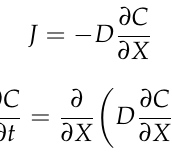
Figure 8. Microstructure and EDS result of interface between the TC particle and the matrix. For TC composites, the vitrified bond begins to soften and wet the alloy surface as the sintering temperature exceeds the glass transition temperature. The increasing temperature helps to increase the atomic activity. Thus, material diffusion will occur at the interface between the alloy and the liquefied vitrified bond. As a result, the Ti 4+ and Cu 2+ ions at the interface will diffuse into the vitrified bond due to their concentration differ- ences. The diffusion process follows Fick’s law, as shown as follows.